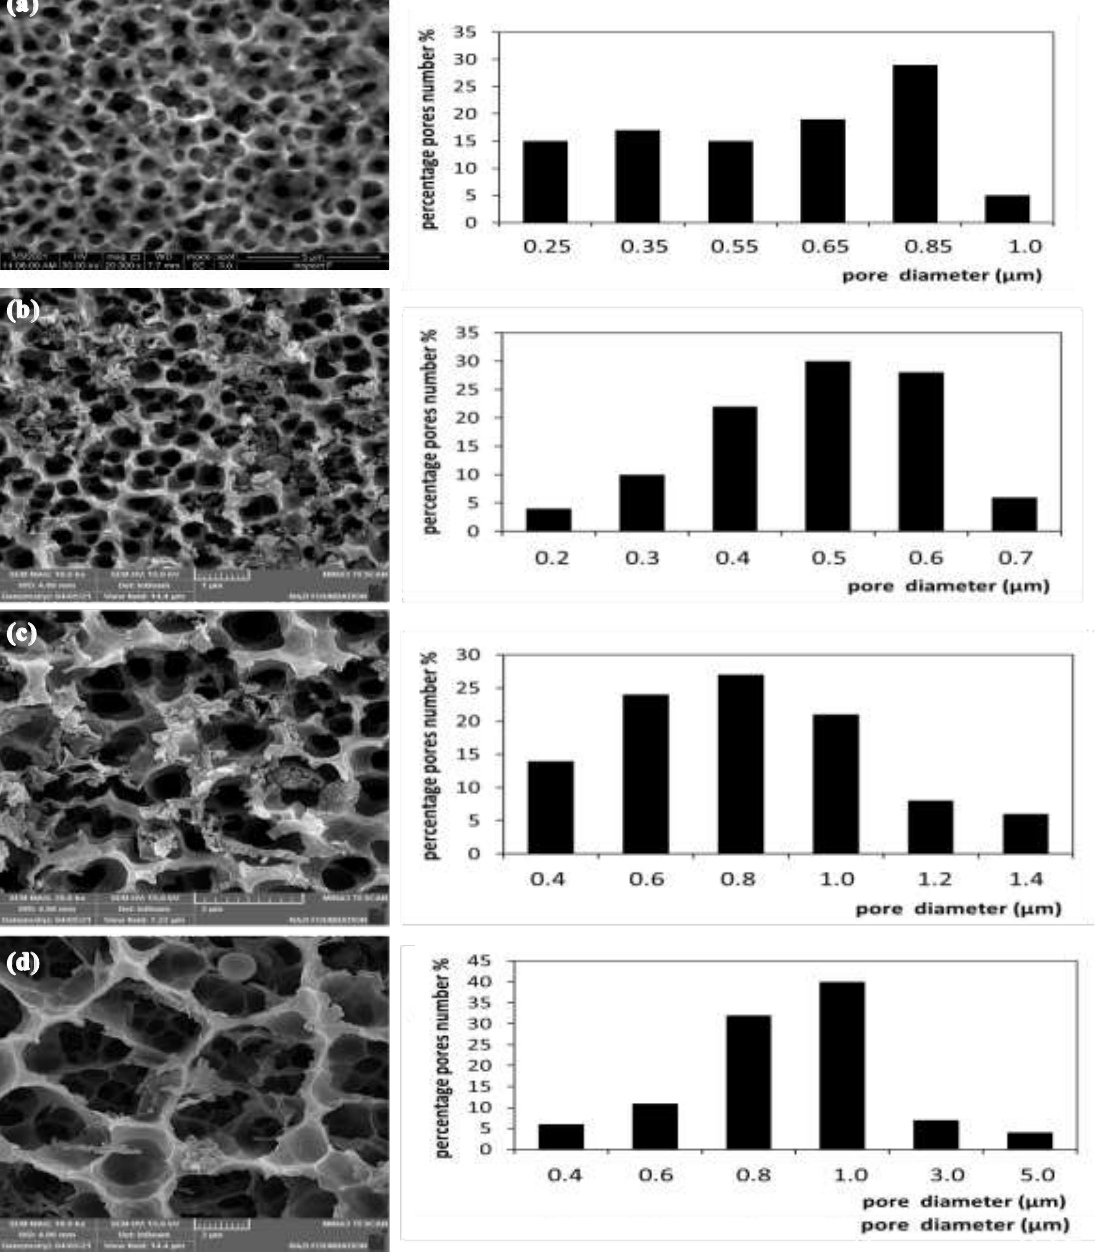
Figure 4: Illustrates the morphology and statistical distributions of samples that are prepared in different laser intensities; a) 10, b) 15 , c) 20, and d) 25 mw/ cm 2 , all samples etched with a current density of 8 mA/ cm 2 and during 20